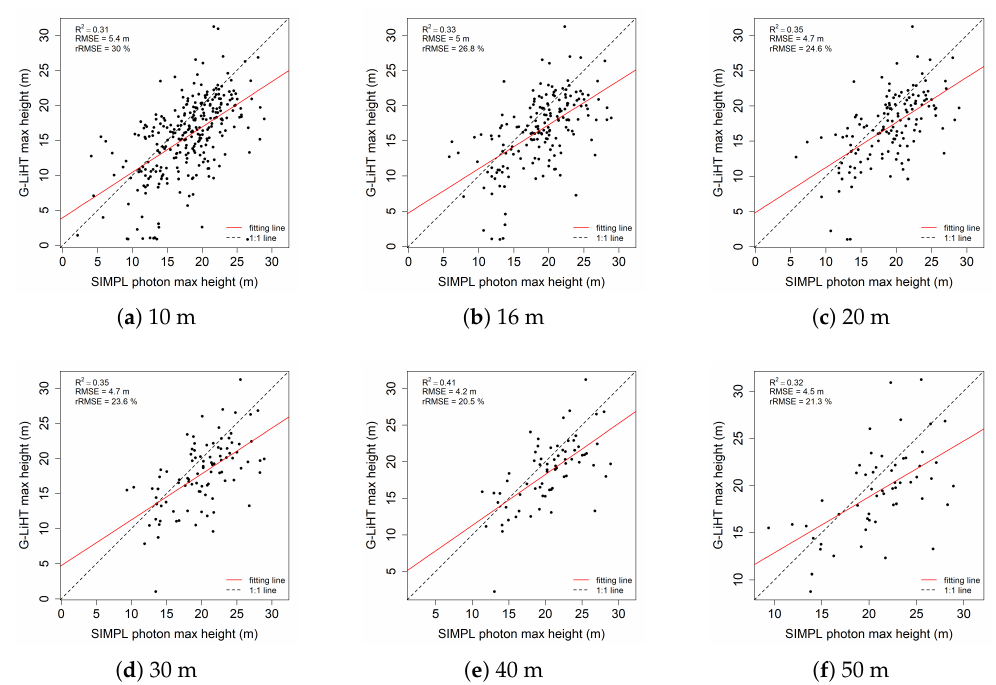
Figure 8. The relationship between the max value of all photon heights from SIMPL and the max value of all return heights from G-LiHT for different scales.